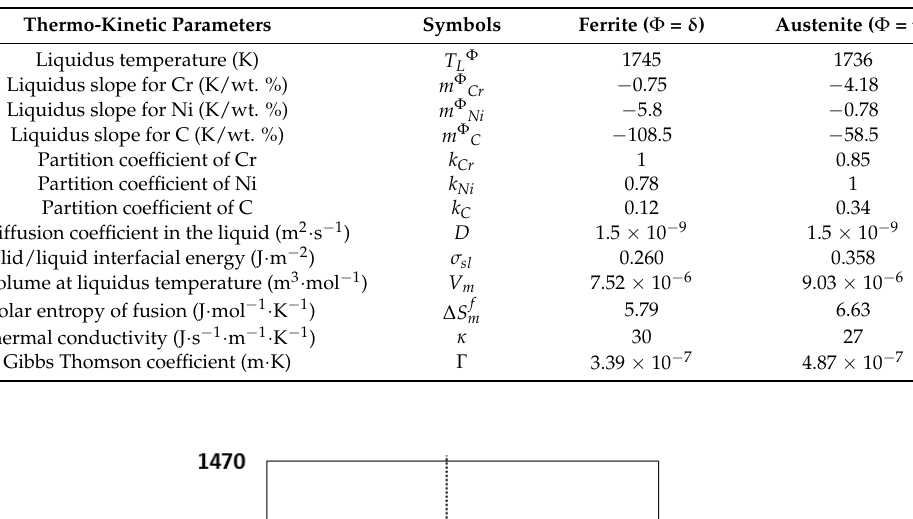
Table 6. Parameters used for the calculation of the tip temperature.